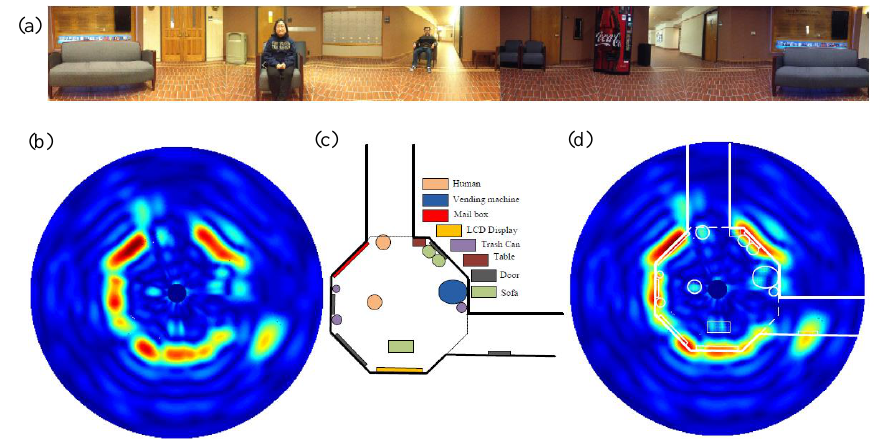
Figure 17. ( a ) The panorama photograph of the experimental environment; ( b ) 2-D location map obtained by FMCW detection mode; ( c ) room layout and objects distribution in the test room; ( d ) the comparison between detection and the actual location.